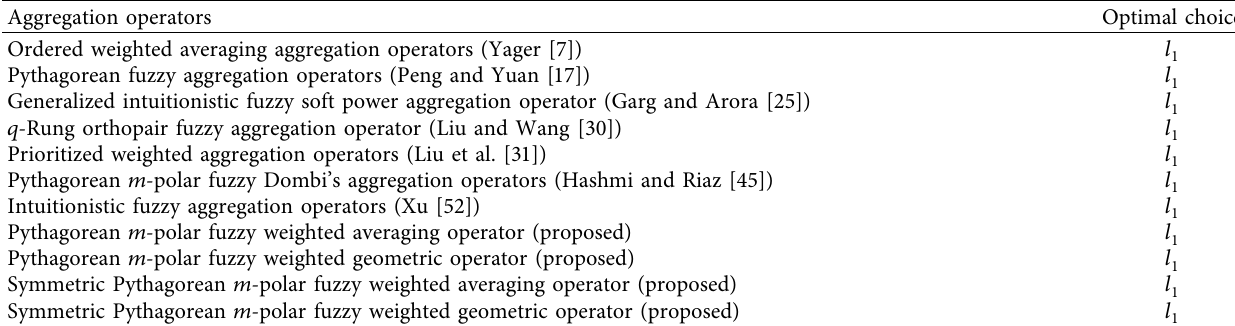
Table 11: Comparison of proposed operators with some existing